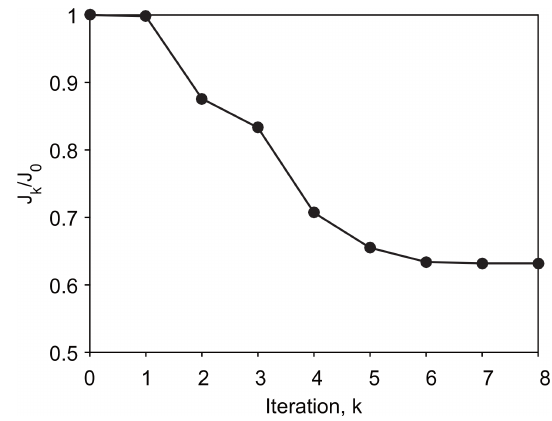
Figure 3. Cost function